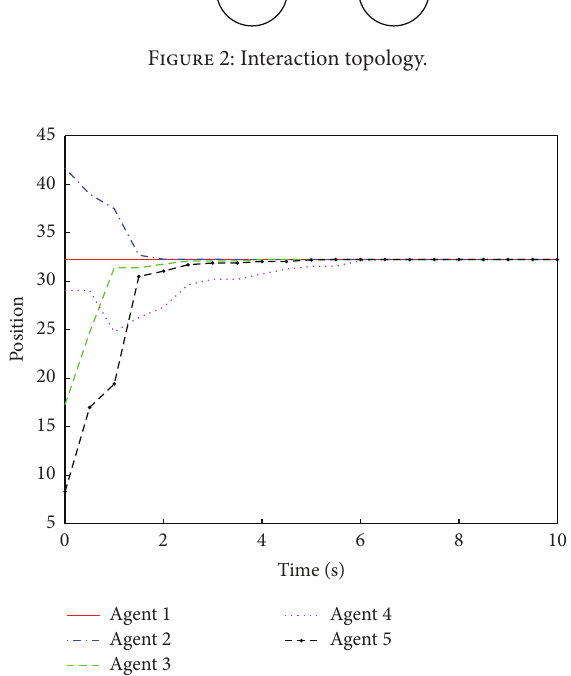
Figure 3: Consensus of single integrator